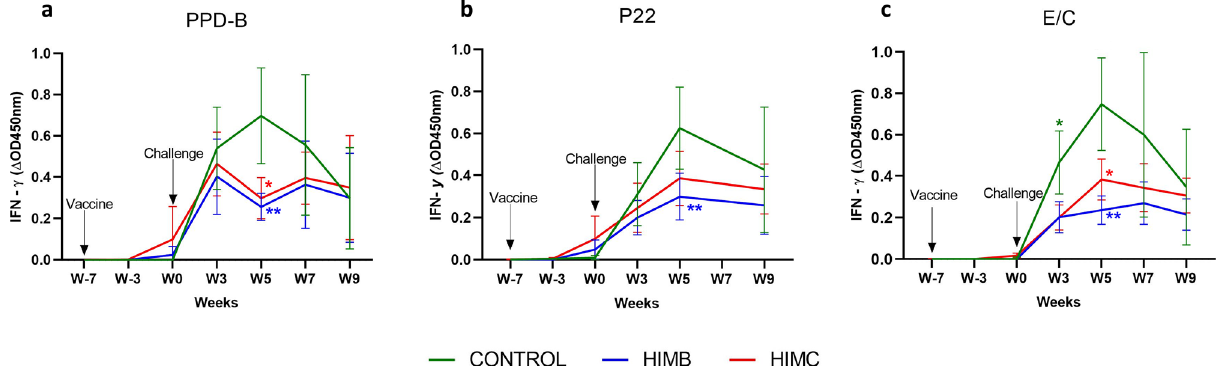
Figure 1. Whole blood IFN-γ responses after vaccination and challenge: The graph shows the IFN-γ levels measured by ELISA. Results are expressed as the increase in optical density (ΔOD 450 mn ± 95% CI). ( a ) Response against bovine tuberculin (PPD-B). ( b ) Response to the P22 complex. ( c ) Response against E/C antigen cocktail. * P < 0.05, ** P < 0.01, Kruskal Wallis test with post hoc Dunn’s test. Groups: Control (n = 7, green), HIMB (n = 7, blue), HIMC (n = 7, red). Two animals of the control group were humanely sacrificed at week